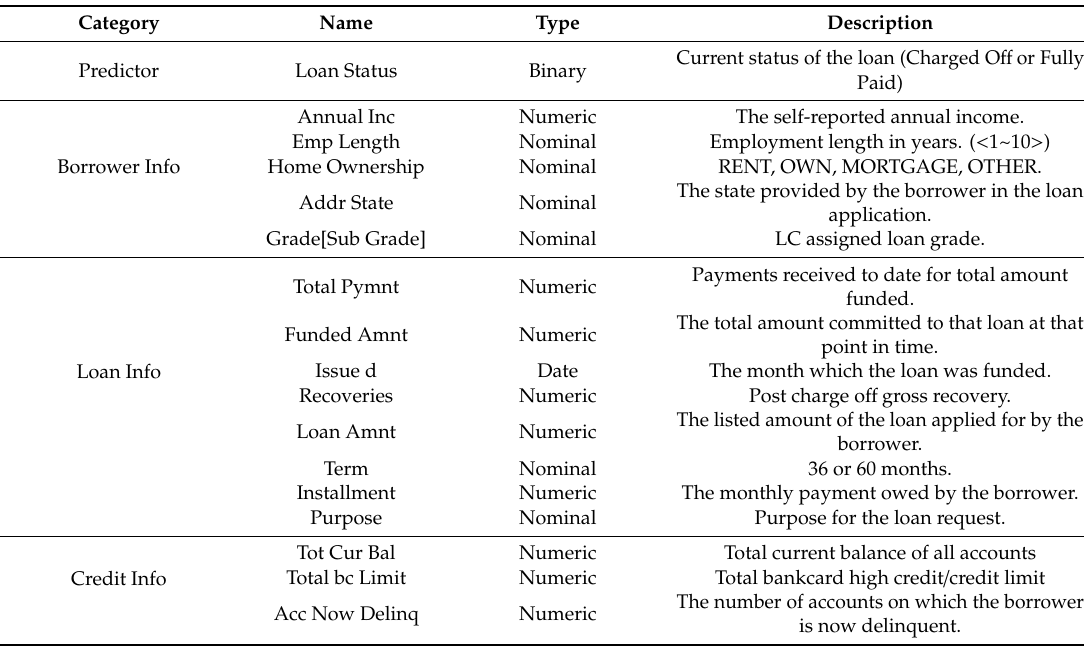
Table 2. The summary of data